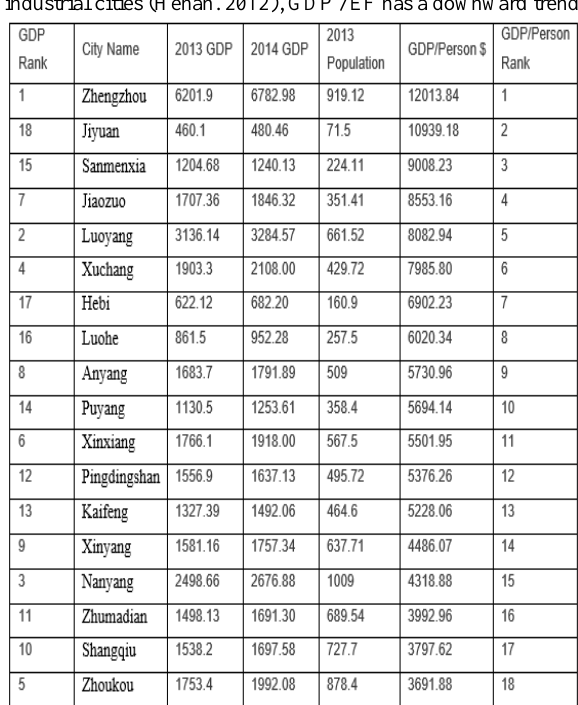
Figure 2. 2013 ecological deficit map of cities